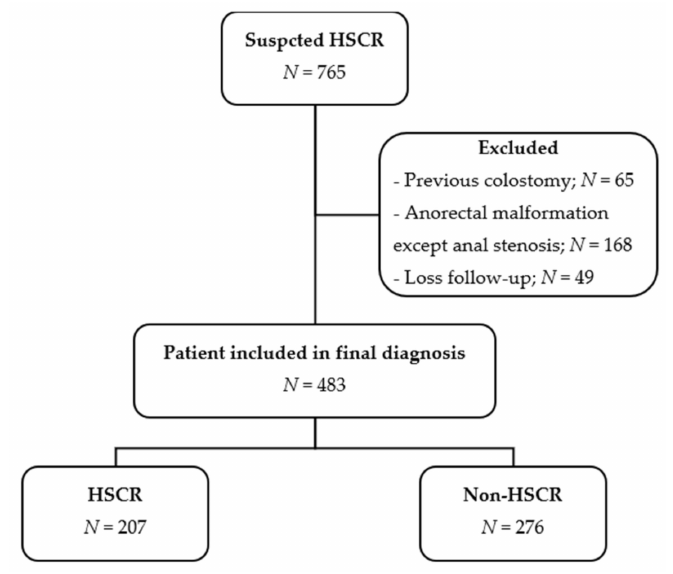
Figure 1. Study flow